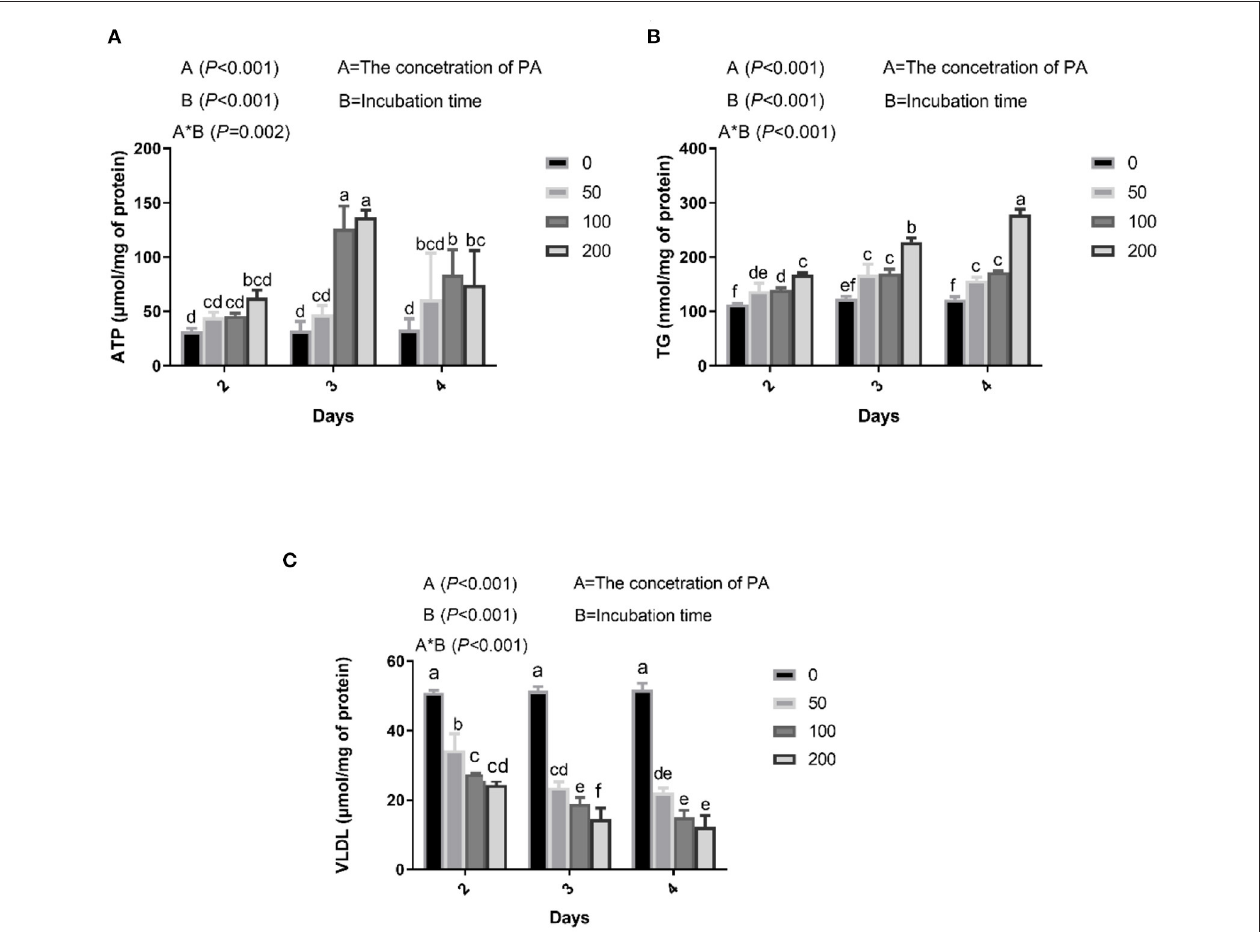
FIGURE 1 | Effects of palmitic acid (PA) on mitochondria and lipid metabolism in bovine hepatocytes. Bovine hepatocytes were treated with different concentrations of PA (0, 50, 100, and 200 µ M) for 48, 72, or 96h. (A) Adenosine triphosphate (ATP) content in bovine hepatocytes. (B) Triglyceride (TG) content in bovine hepatocytes.